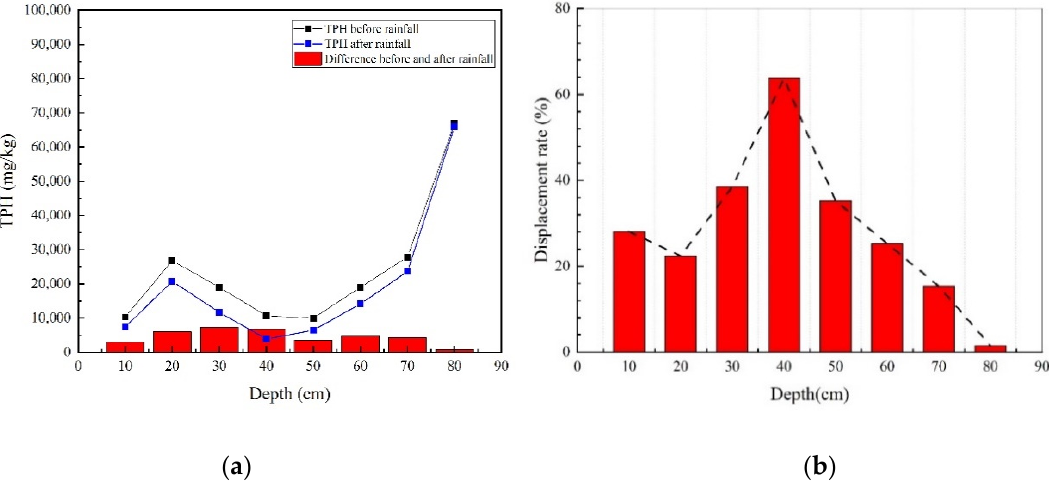
Figure 7. ( a ) TPH concentration before and after rainfall and ( b ) diesel displacement rates at different depths in the M-C-M tank.